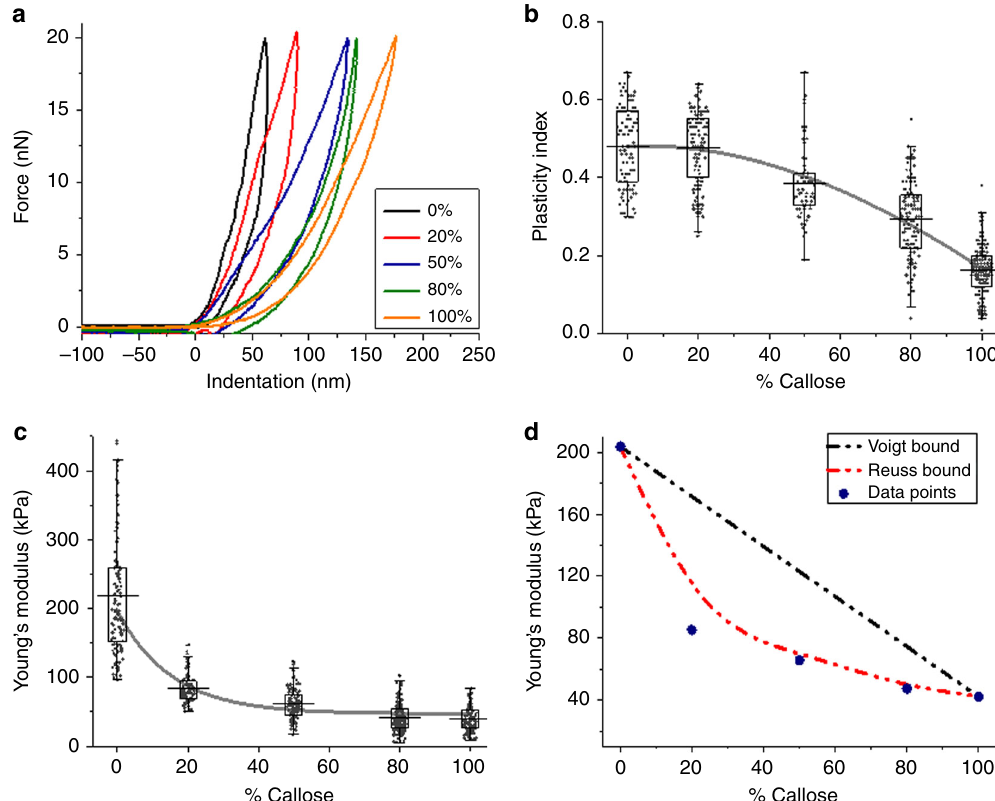
Fig. 2 Nano-mechanical properties of the hydrogels. a shows typical loading and unloading force curves obtained for the different hydrogels (0% callose in black, 20% in red, 50% in blue, 80% in green an 100% in orange) using AFM-nanoindentation. b shows plasticity values as a function of callose concentration; the solid line is presented to guide the eye. c shows the calculated Young ’ s modulus (data points) as a function of the callose concentration in the hydrogel (solid line is to guide the eye). d Mean Young ’ s modulus (blue circles, individual data points displayed in c are represented in relation to values obtained as a result of applying the Voigt and Reuss hypothetical model (dashed lines in black and red, respectively). Box plots in b and c represent the fi rst (25%) and third (75%) quartiles, the central horizontal line is the mean, and outliers at the 1% and 99% level are indicated by the whiskers, the data points are averages for 3 individual samples, with 5 areas imaged for each sample